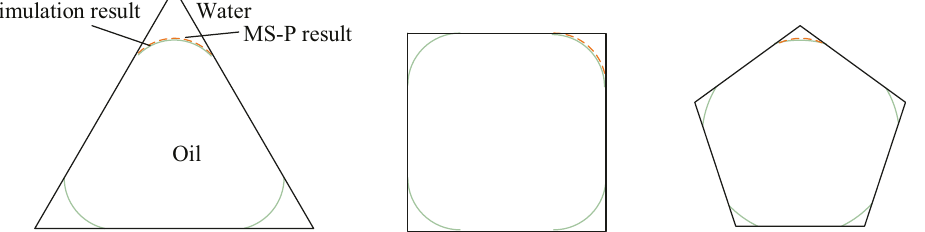
Figure 4: Interfaces obtained by the simulation and by the MS-P method.